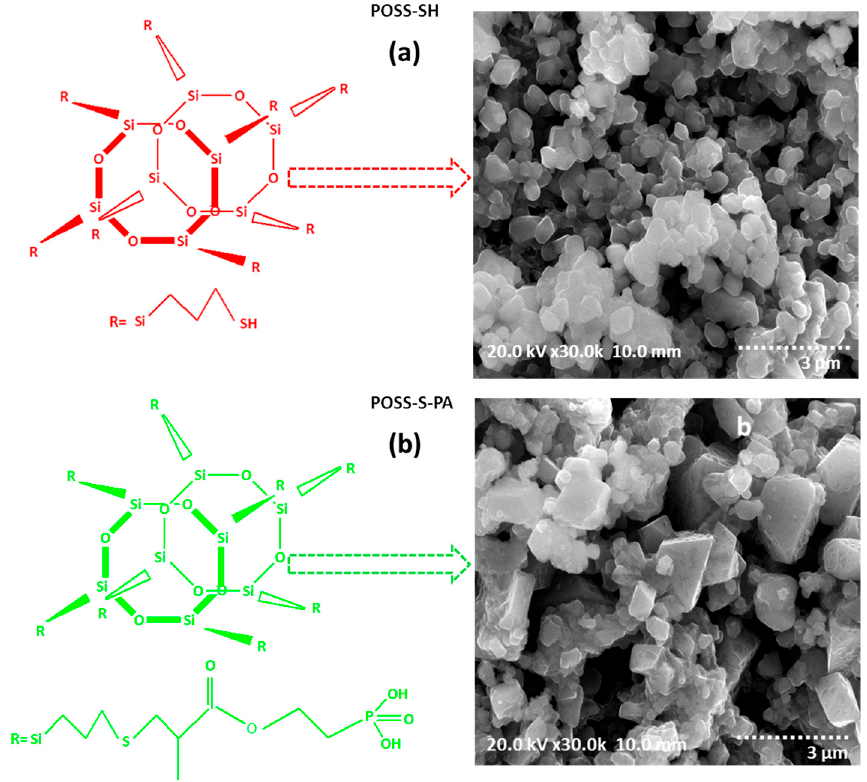
Figure 4. Structure and SEM image of ( a ) POSS-SH and ( b ) POSS-S-PA hybrids.